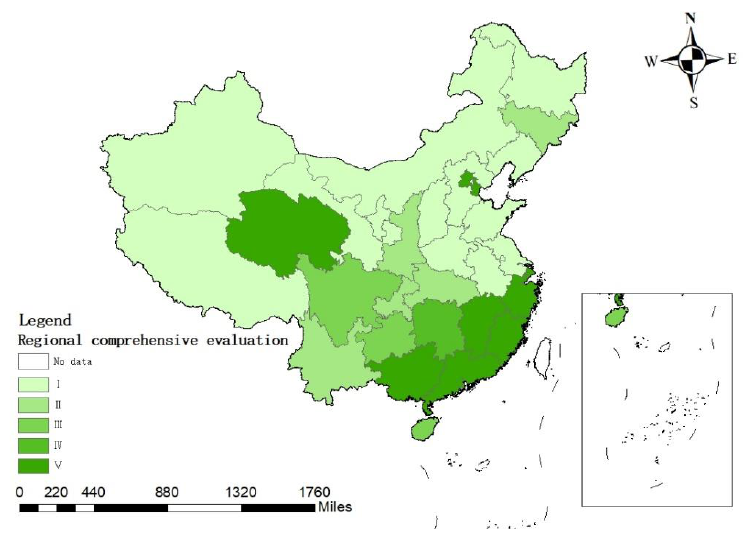
Figure 2. Regional comprehensive evaluation results of the sustainability of water resources use in China.